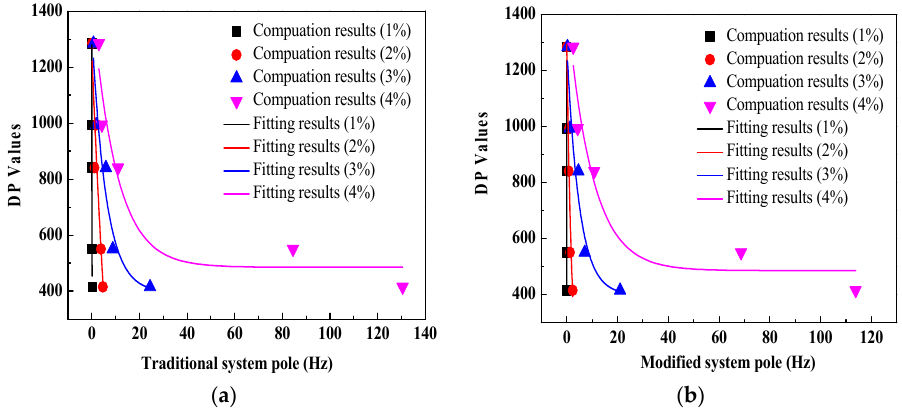
Figure 11. Comparisons of fitting relationships between system poles and DP values. ( a ) Traditional system poles; ( b ) modified system poles. Table 1. Fitting equations between the traditional system pole and DP values.